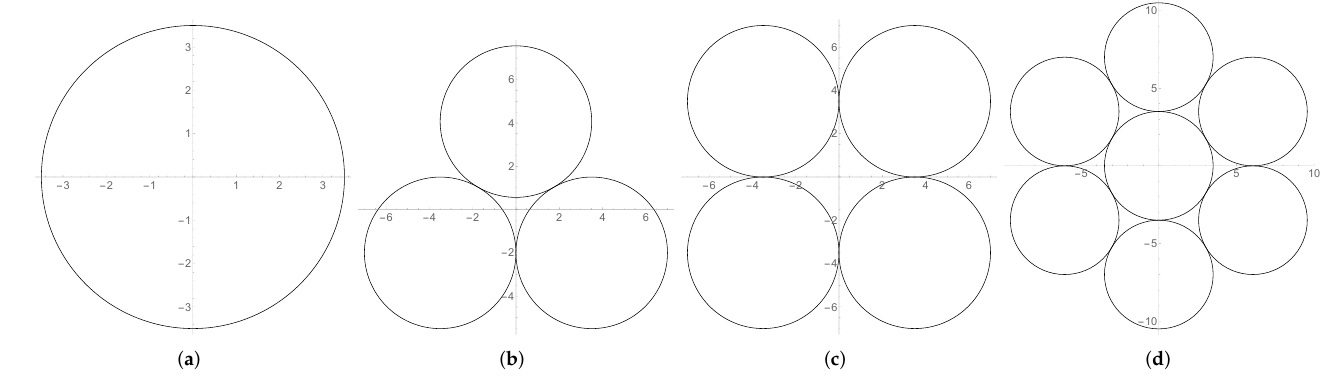
Figure 1. Orbit traps used in [17]. ( a ) one orbit trap; ( b ) three orbit traps; ( c ) four orbit traps; and ( d ) seven orbit traps.